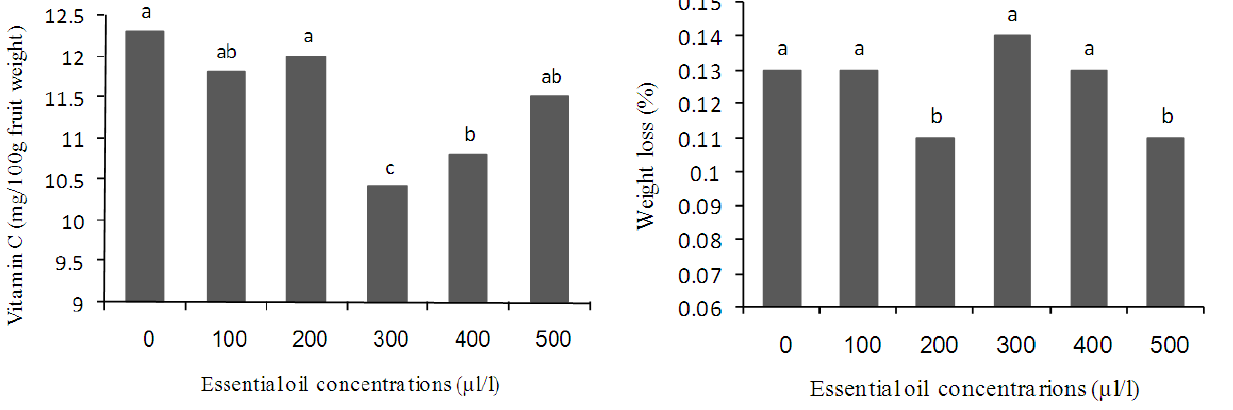
Fig. 5. The effect of essential oil treatment on weight loss of ‘Bi-